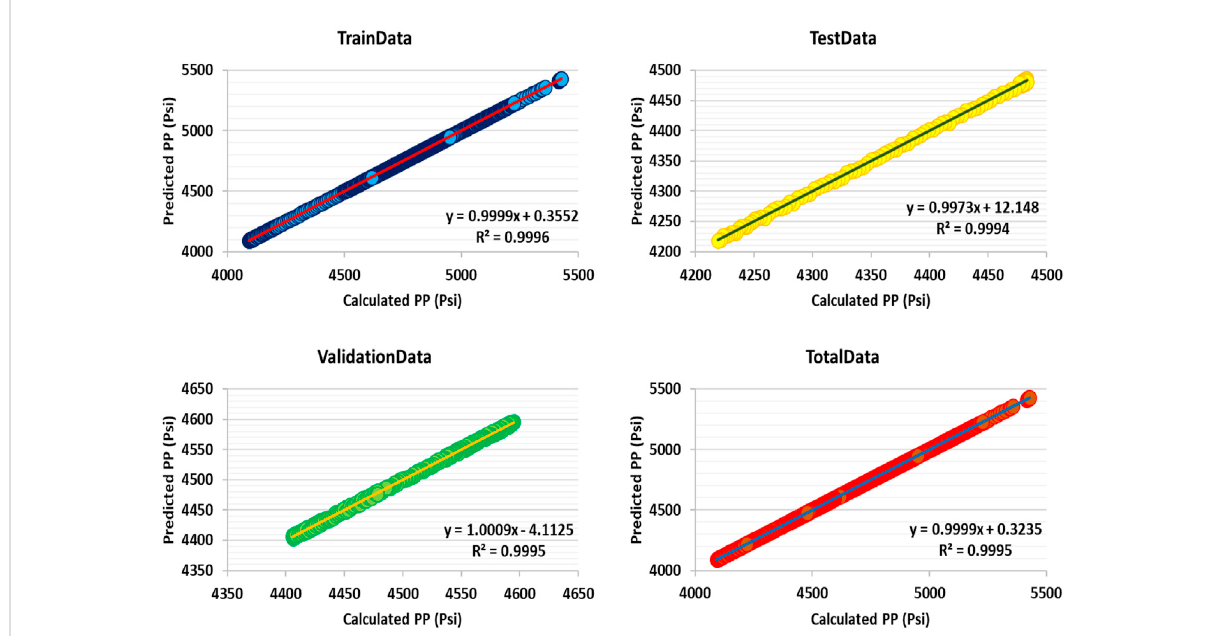
FIGURE 5 Cross plot for PP prediction by GS-GMDH based on two wells F 1 and F 2 data points (1511 data